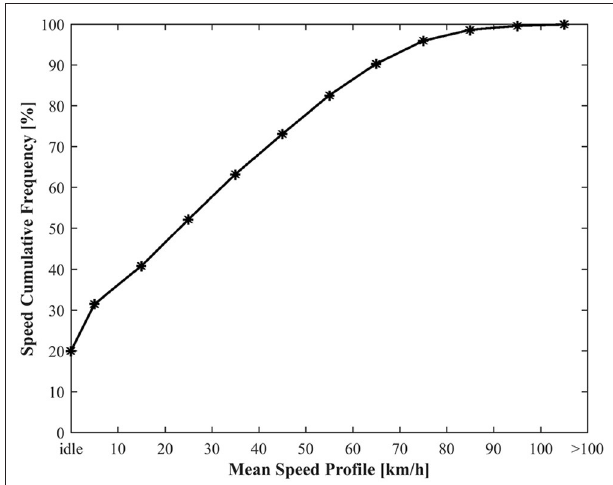
FIGURE 5 | Cumulative frequency distribution of instantaneous speed of the measured taxis.